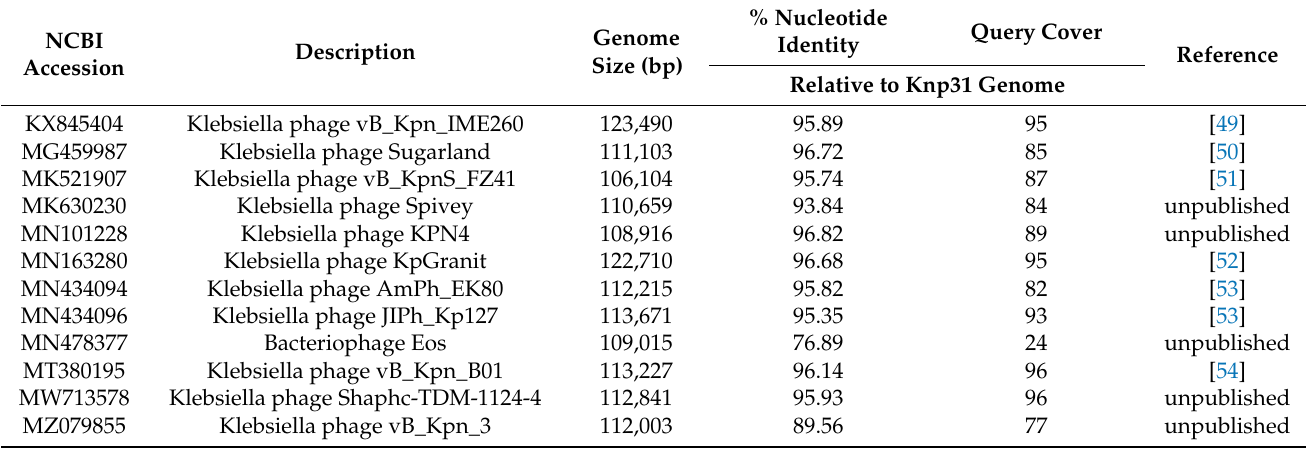
Figure 3. Annotated genome map of phage Kpn31. GC skew, G + C content, and predicted CDS are shown. The middle ring indicated the GC content (black), and the innermost ring represented the GC skew of Kpn31 genome. Blue arrows in the outer ring are annotated coding sequences (CDSs) numbered according to the annotation in Supplementary Table S1. Red arrows correspond to tRNAs. The arrows represent the direction of transcription (strand + or − ). Table 2. Phages that clustered together with phage Kpn31 in the network analysis